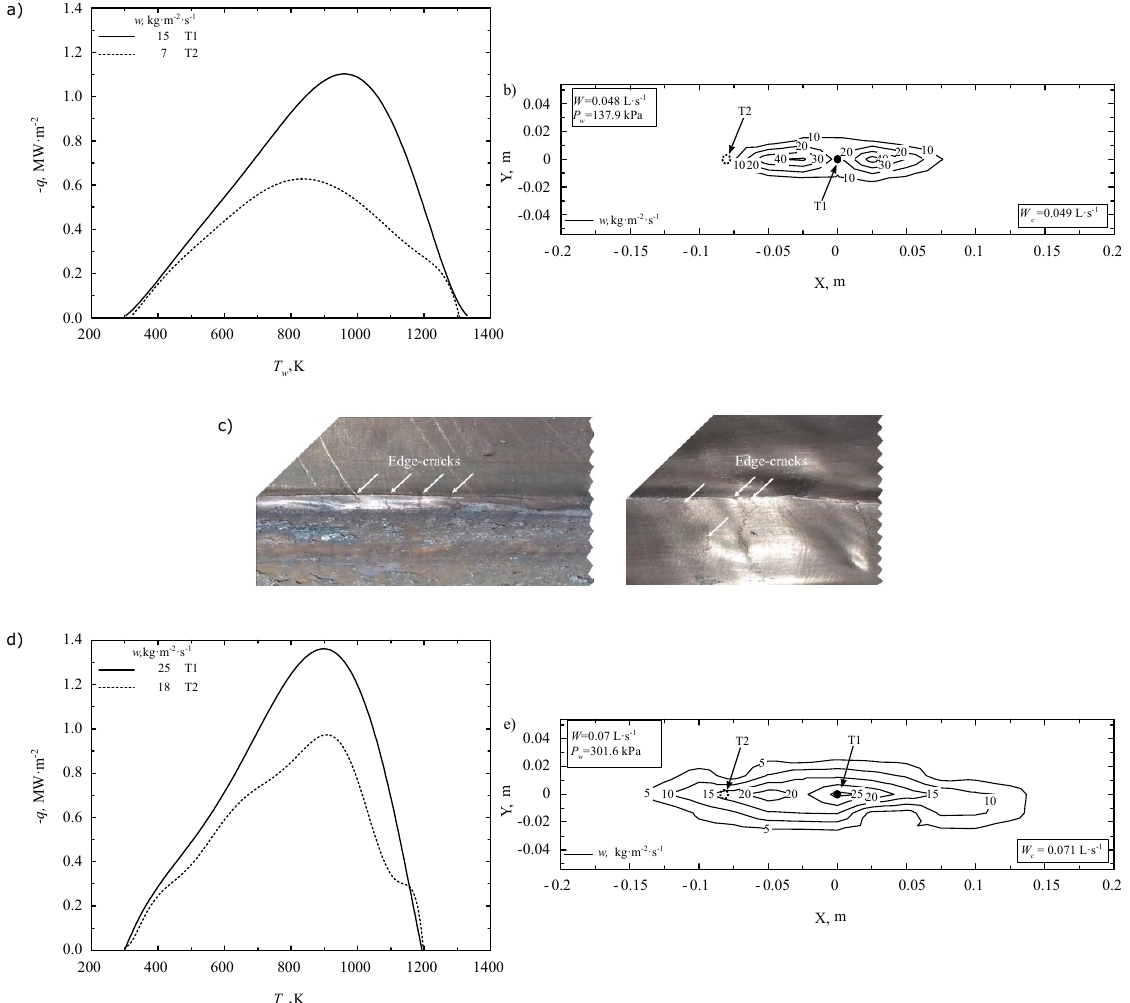
Figure 7. Heat flux curves and impingement density maps of the 632.644 nozzle at different pressures and distances. ( a ) and ( b ) 137.9 kPa with 0.15 m, ( c ) edge-cracks on the slab surface, ( d ) and ( e ) 301.6 kPa with 0.25 m. To validate the measured heat fluxes, Equation (2) for one-dimensional heat diffusion